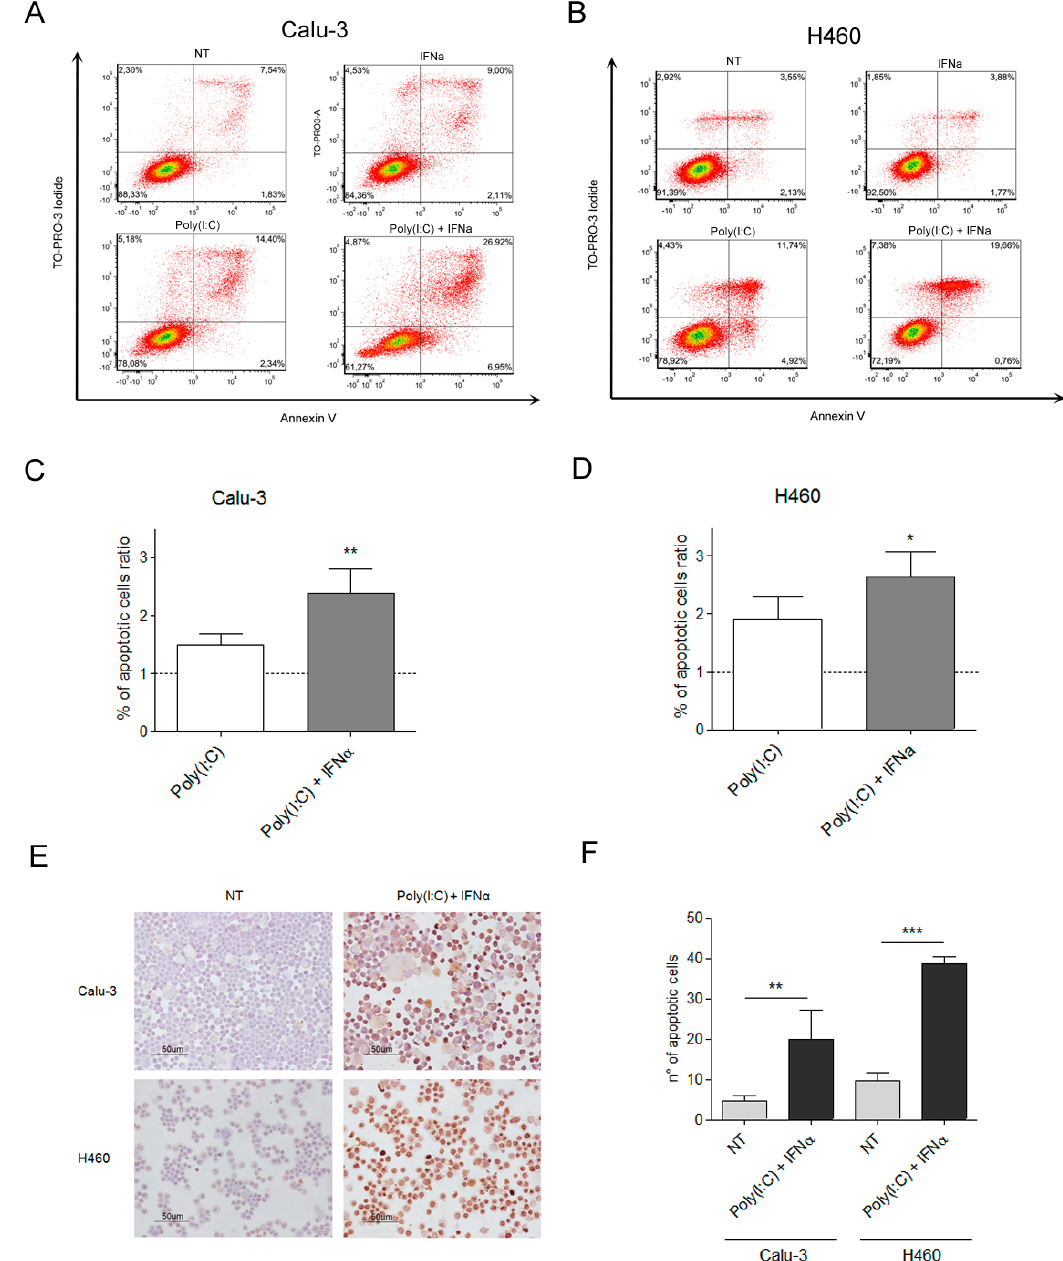
Figure 1. TLR3 activation by Poly(I:C) induces apoptosis in lung cancer cell lines. To determine the percentage of apoptotic cells on TLR3 activation in lung cancer cells, Calu3 ( A , C ) and H460 ( B , D ) cells were left untreated (NT) or treated with Poly (I:C), IFN α , or their combination for 48 h. Harvested cells were processed by annexin V apoptosis assay. To evaluate the apoptotic cells fractions (expressed as percentage of total number of cells evaluated) of each sample, we considered cells in early and late apoptosis phases, then combining the percentage of cells positive for Annexin V, regardless of TO-PRO-3 staining. Approximately 30% of cells were apoptotic on TLR3 activation in both lung cancer cell lines. The experiment shown in panels A and B is representative of four independent experiments. To calculate the percentage of apoptotic cells ratios, the obtained percentages of total apoptotic cells treated with Poly(I:C) + IFN α were divided for the percentage of total apoptotic cells of the untreated samples, set as reference. The apoptotic ratio increase was confirmed by TUNEL assay ( E , F ). * p value < 0,05, ** p value < 0.005, *** p value < 0.001.